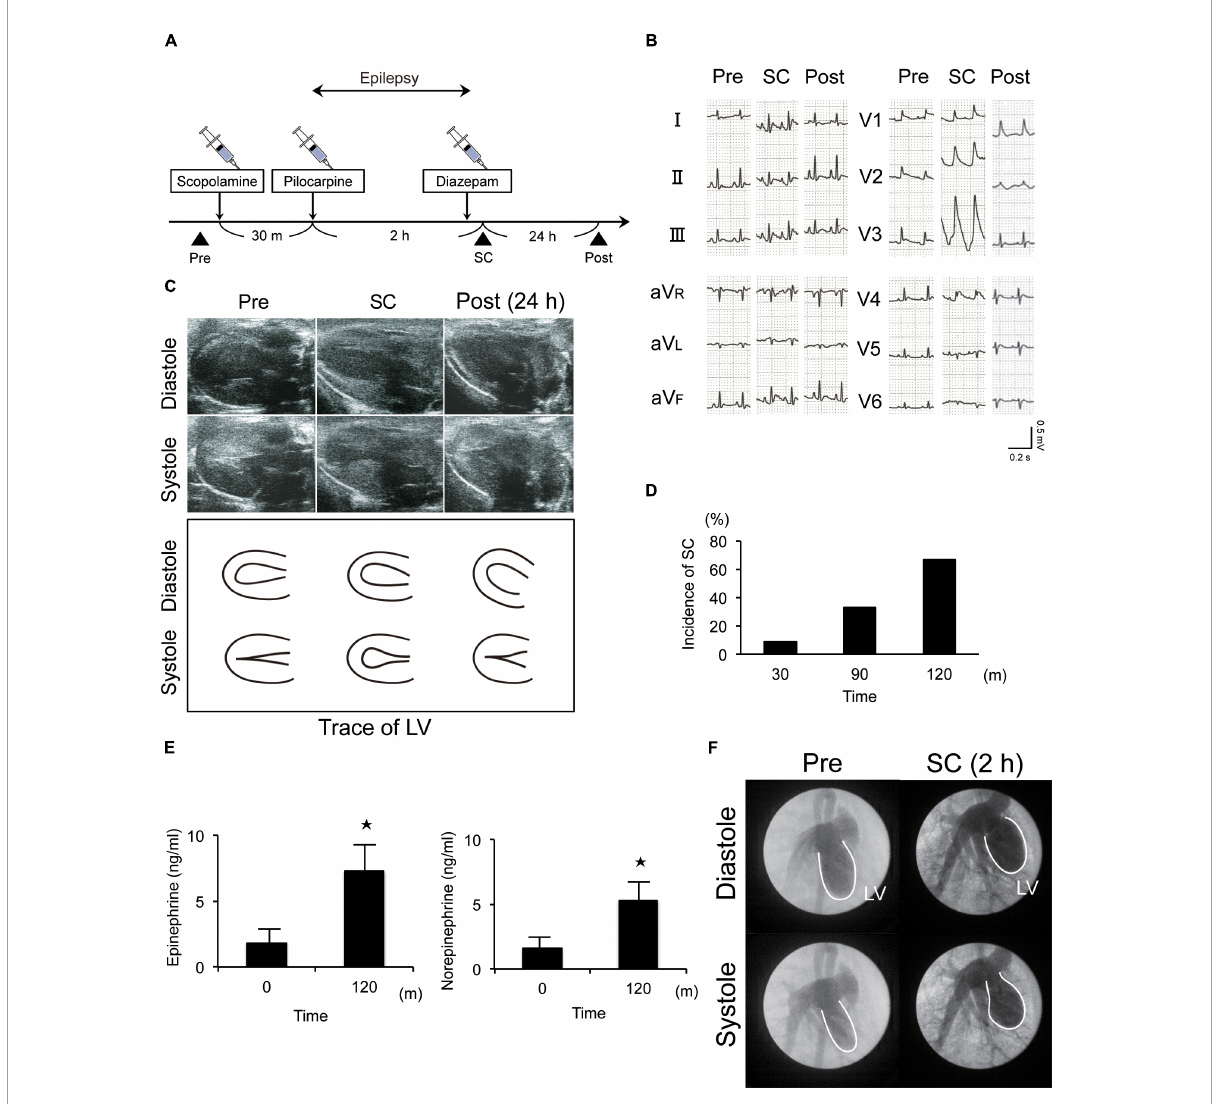
FIGURE1 New animal model of epilepsy-induced stress cardiomyopathy (SC). (A) Protocol for the induction of SC in Wistar rats using pilocarpine. (B) Electrocardiograms revealing typical ST elevation during SC. Pre, pre-inducing epilepsy; Post, post-inducing epilepsy; (C,F) Echocardiography ( c ) and left ventriculography (F) revealed that wall motion of the left ventricle (LV) apical segment was akinetic or dyskinetic during SC. (D) Incidence of epilepsy-induced SC ( n = 9). (E) Upregulated serum epinephrine, norepinephrine, and dopamine levels 2 h after the induction of epilepsy ( n = 4). Where appropriate, data are provided as the mean ± SD. * P < 0.05 compared with 0 min (E)